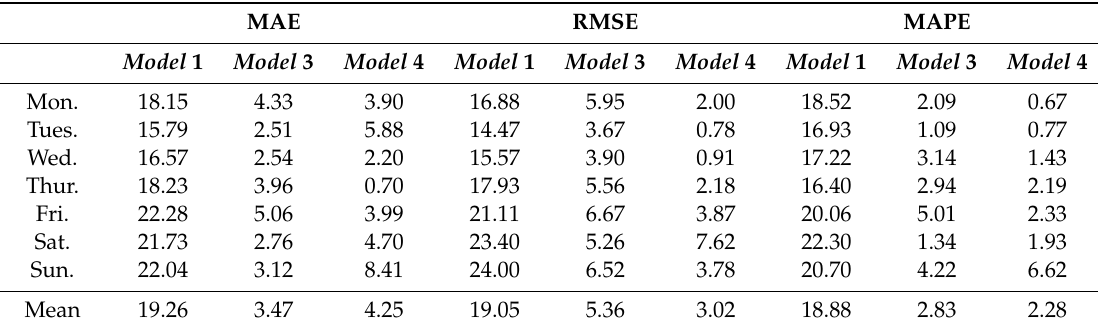
Table 6. Relative improvements of Model 2 over the other three models from Monday to Sunday (%). MAE RMSE MAPE Model 1 Model 3 Model 4 Model 1 Model 3 Model 4 Model 1 Model 3 Model 4 Mon. 18.15